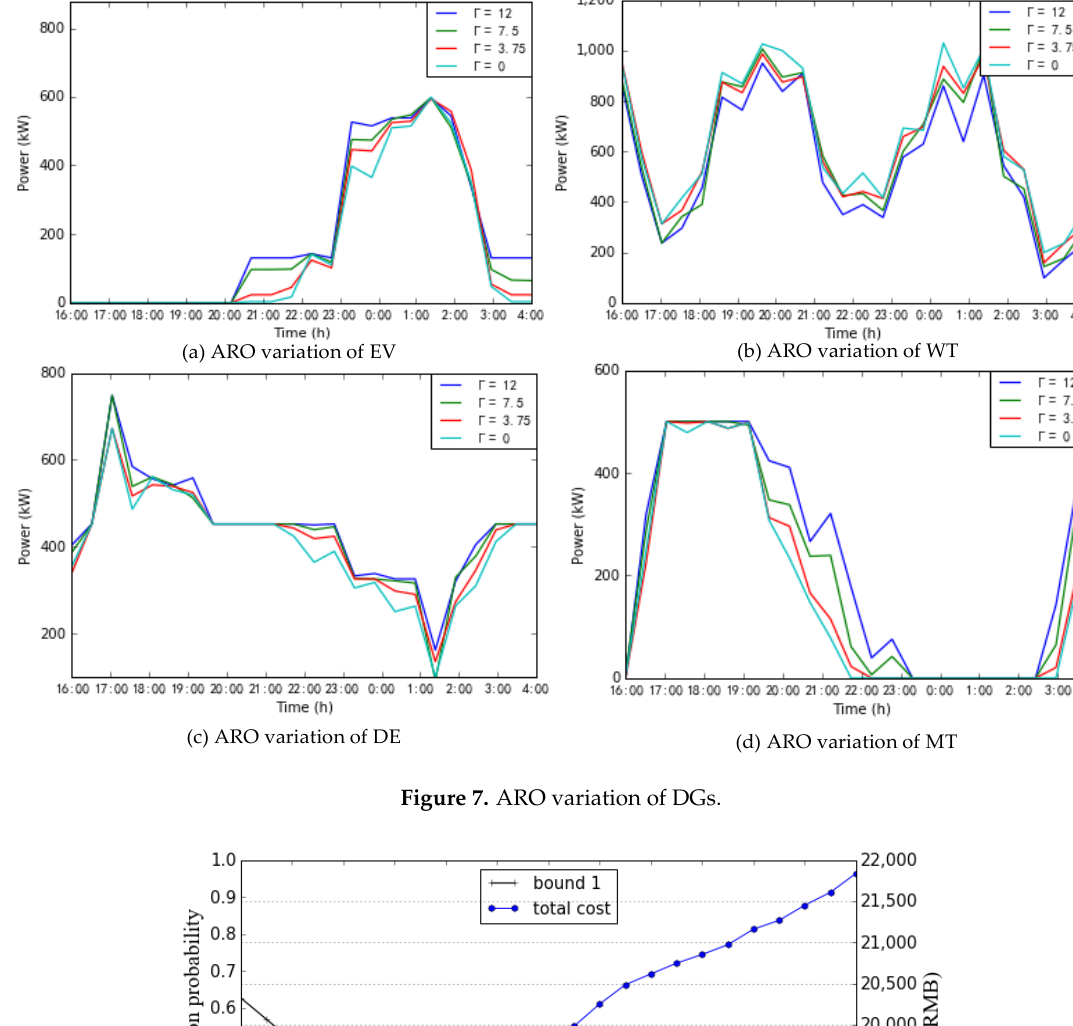
Figure 7. ARO variation of DGs.